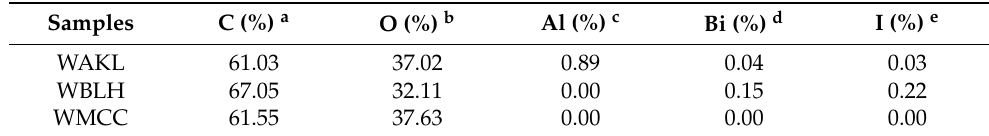
Table 2. Elemental composition of fibres.